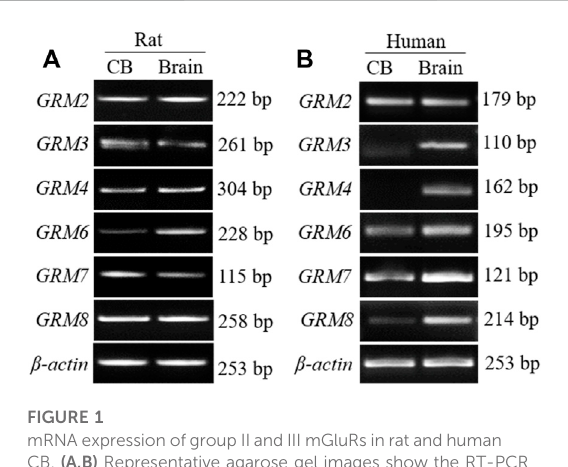
FIGURE 1 mRNA expression ofgroup II and III mGluRs in rat and human CB. (A,B) Representative agarose gel images show the RT-PCR products of group II and III mGluR subunit in rat and human CB (CB, left lanes in (A,B) . RNA extracted from rat or human prefrontal cortex was used as positive control (Brain, right lanes in (A,B) . CB, carotid